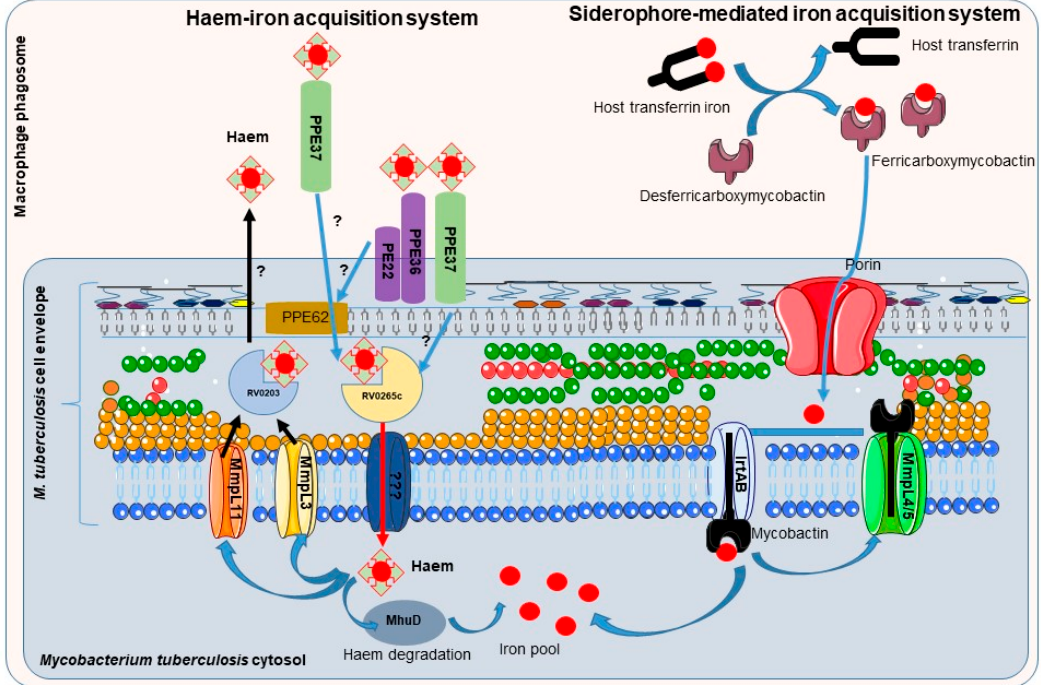
Figure 5. Heme-iron and siderophore-mediated iron acquisition of Mycobacterium tuberculosis in macrophage phagosome (adapted from [55]). M. tuberculosis has both heme and non-heme iron uptake pathways. M. tuberculosis secretes and express on its outer membrane PPE36 / 37 which can bind to heme and induce heme importation across the outer membrane. Then heme is linked to Rv0265c which facilitate heme transport to the cytosol using an unknown heme importer. In the cytosol, heme